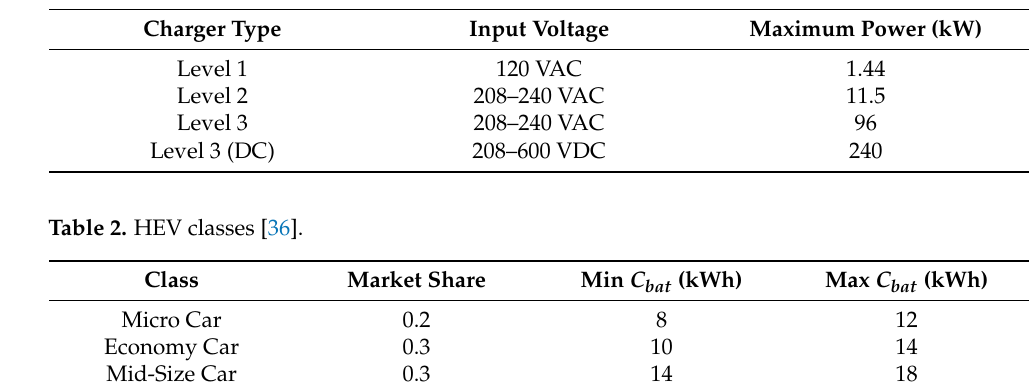
Table 1. Charger type in HEVs [36].